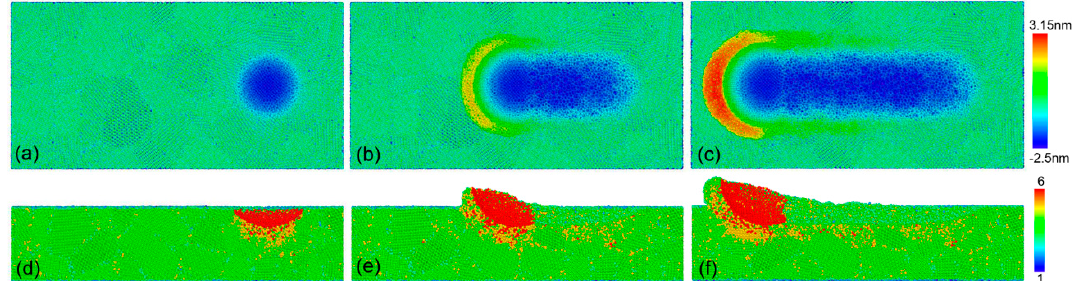
Figure 2. Deformation behavior of a polycrystalline silicon substrate with average grain size of 4 nm for the scratching distance of 0 nm ( a , d ); 10 nm ( b , e ); and 20 nm ( c , f ) at the scratching depth of 2 nm. In the figures ( a – c ), atoms are colored according to their heights in the z direction, while in the figures ( d – f ) atoms are colored according to the coordination number. ( a – c ) are top views and ( d – f ) are front views of the polycrystalline silicon.